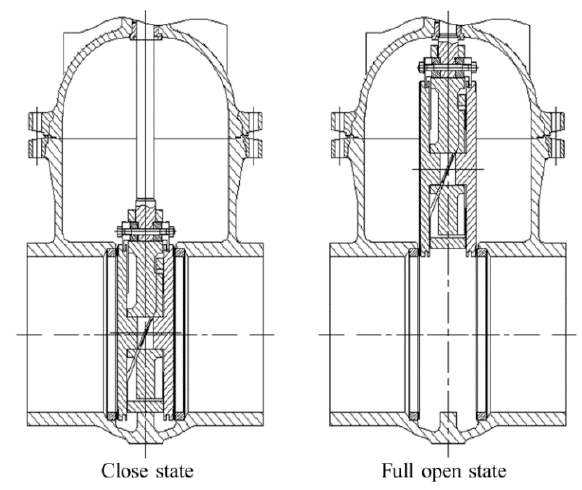
Figure 1. The structure of the wedge-type double disk parallel gate valve.